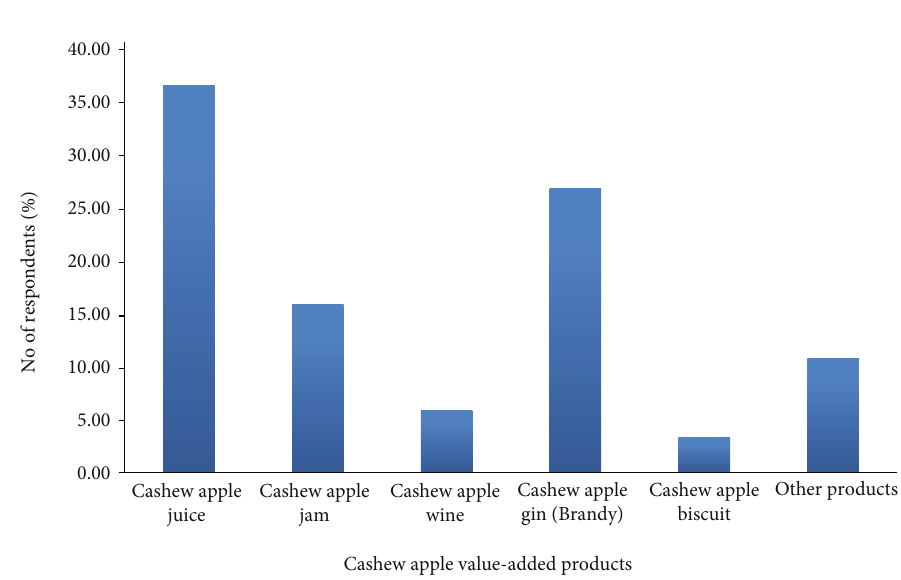
Figure 2: Cashew stakeholders ’ knowledge about the existence of cashew apple value-added products. Note: others refer to responses outside the thematic areas.